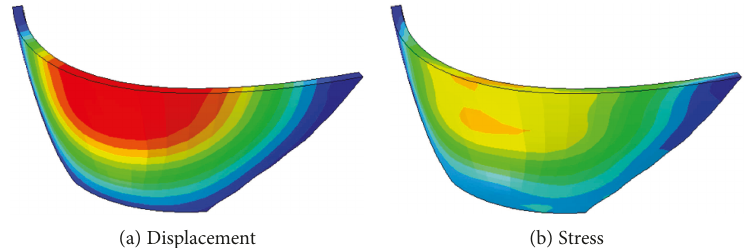
Figure 7: Displacement and stress distribution of arch dam under seismic e ff